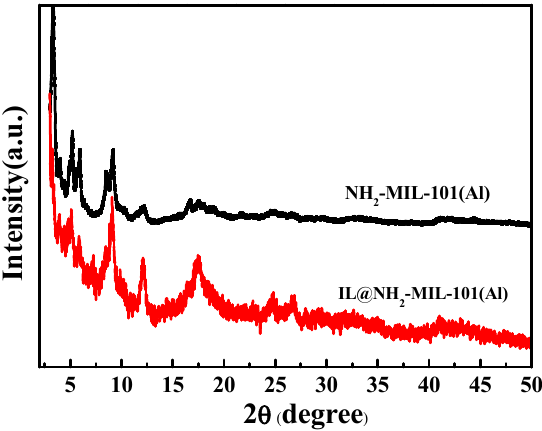
Figure 1. XRD patterns of NH 2 -MIL-101(Al) and IL@NH 2 -MIL-101(Al).